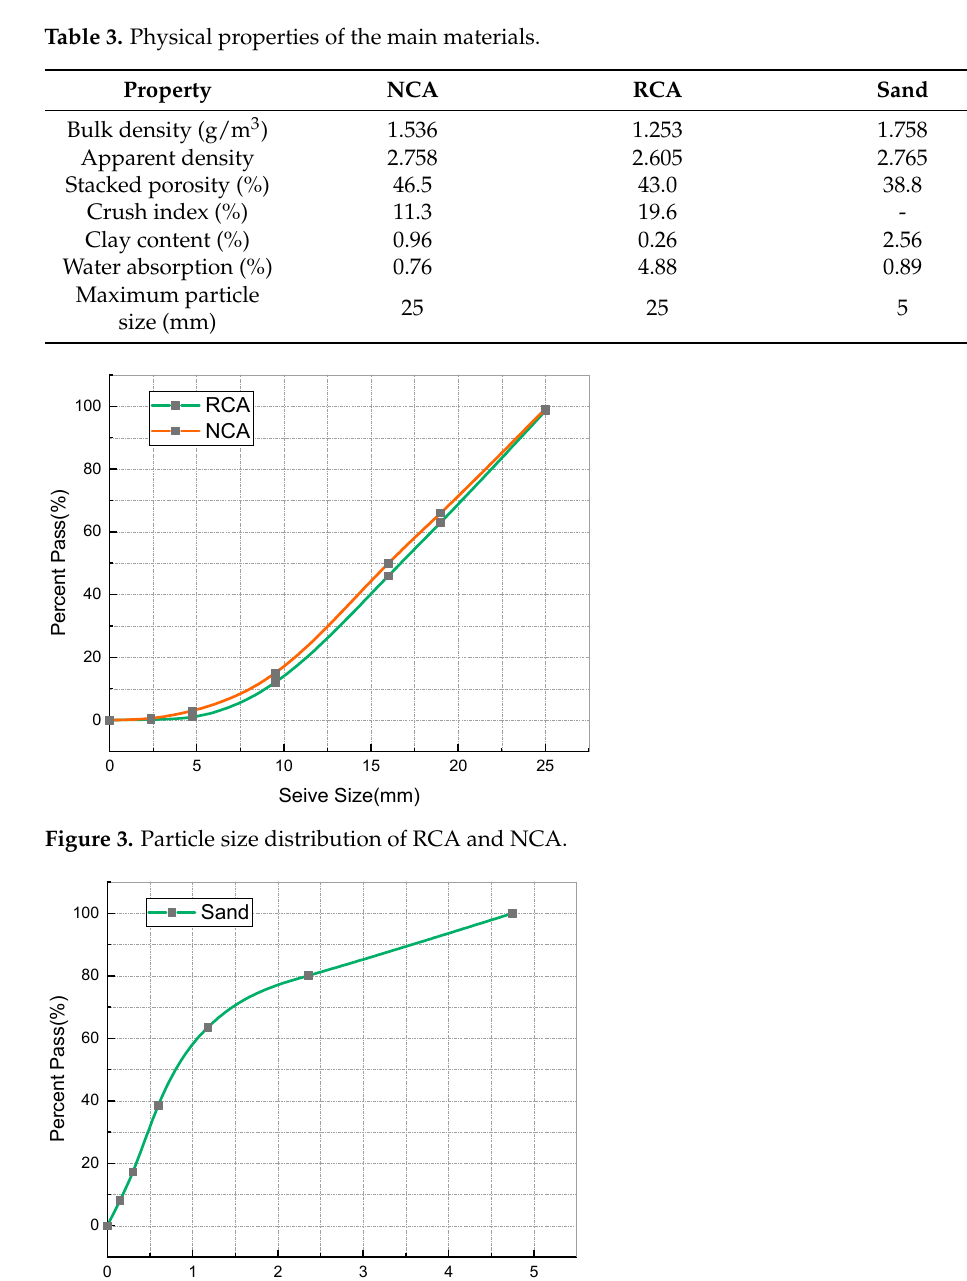
Figure 4. Particle size distribution of river sand.